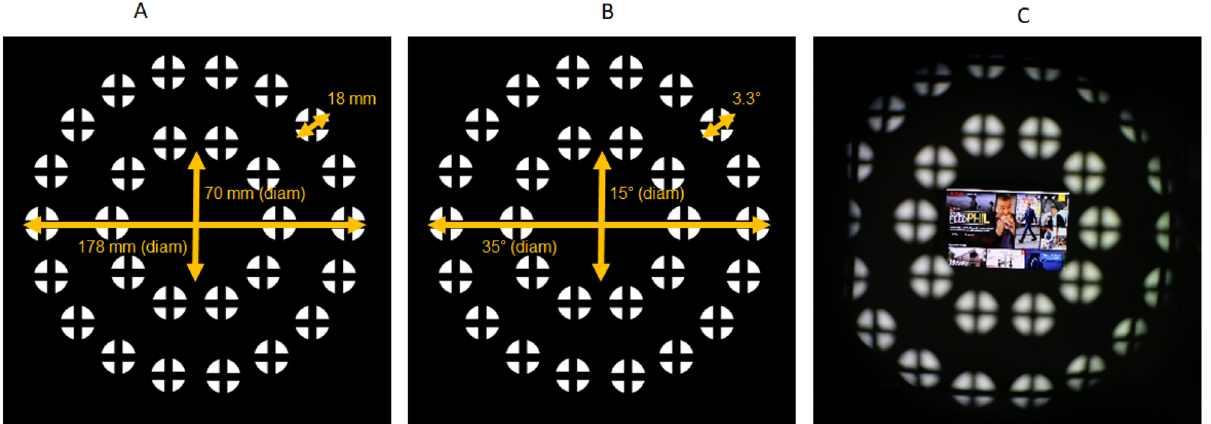
Figure 2. The extent of the stimulus in millimeters ( A ) and degrees ( B ). The image on the far right ( C ) shows the “approximate" subject’s view through the test eye through the ANWAR setup.